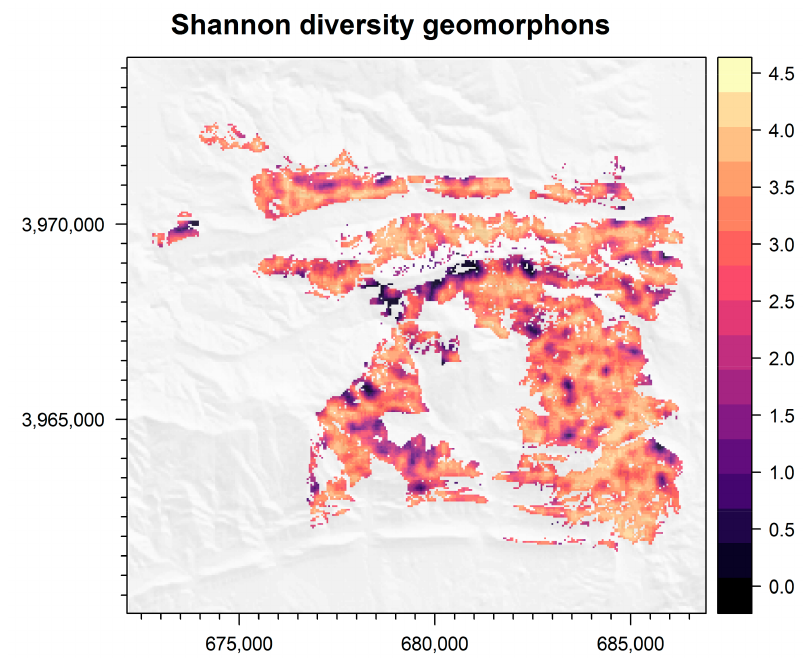
Figure 8. Shannon entropy map of geomorphon classes.